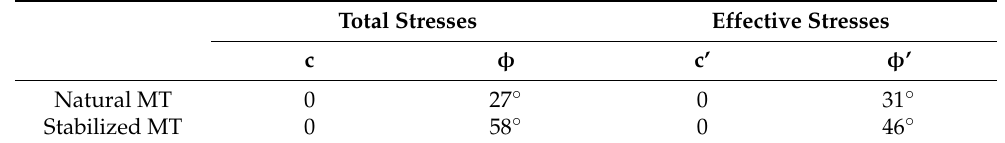
Table 8. Shear strength parameters of the mine tailing before and after stabilization (peak deviatoric stresses).